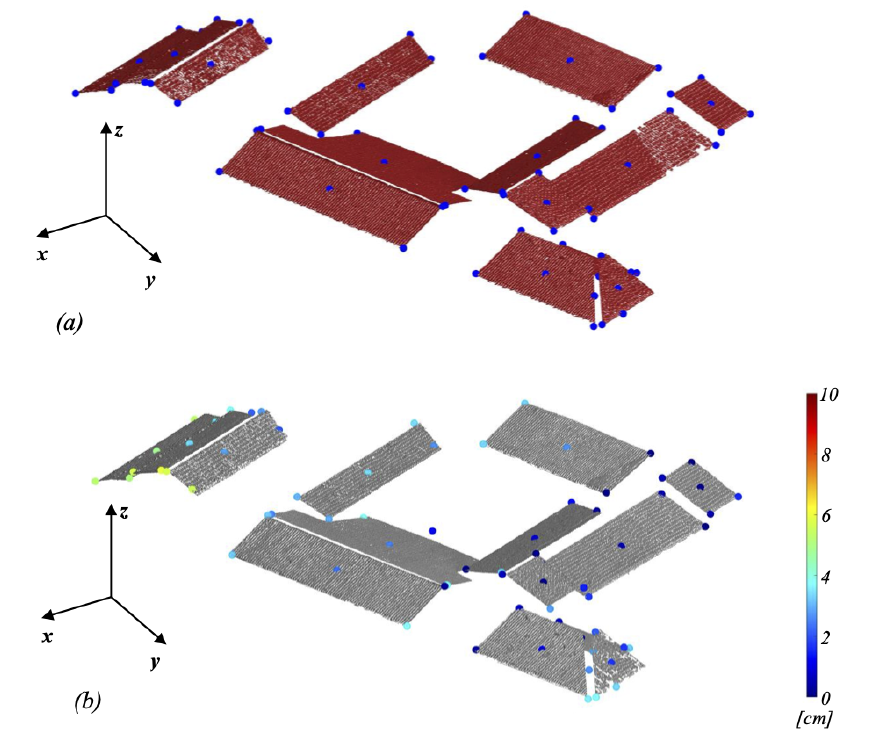
Figure 8. Results of registration method: ( a ) reference points superimposed on “moving” point cloud; ( b ) final position of reference points superimposed on “fixed” point